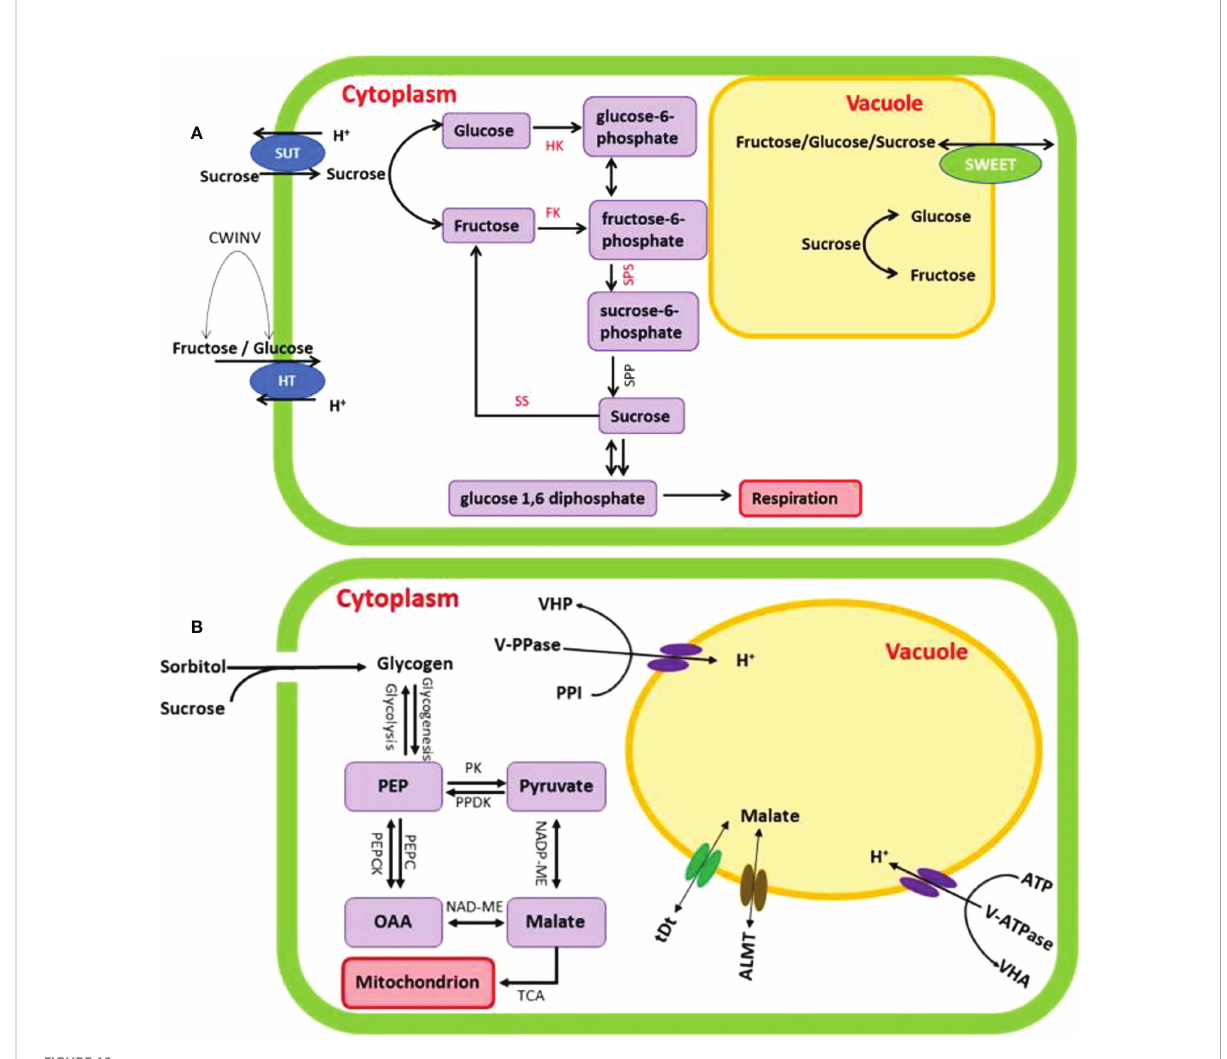
FIGURE 10 Proposed schematic representation of soluble sugars (A) and malic acid (B) metabolic pathway in fruit cell. SUT, sucrose transporters; CWINT, cell wall invertase; HT - hexose transporters; HK, hexokinase; FK, fructokinase; SPS, sucrose phosphate synthase; SS, sucrose synthase; SPP, sucrose-phosphate phosphatase; SWEET, sugars will eventually be exported transporter; PK, phosphokinase; PPDK, pyruvate phosphate dikinase; PEPC, phospho enol pyruvate carboxylase; NADP-ME, NADP-dependent malic enzyme; NAD-MDH, NAD-malate dehydrogenase; ALMT, aluminium activated malate transporter; tDt, terminal deoxynucleotidyl